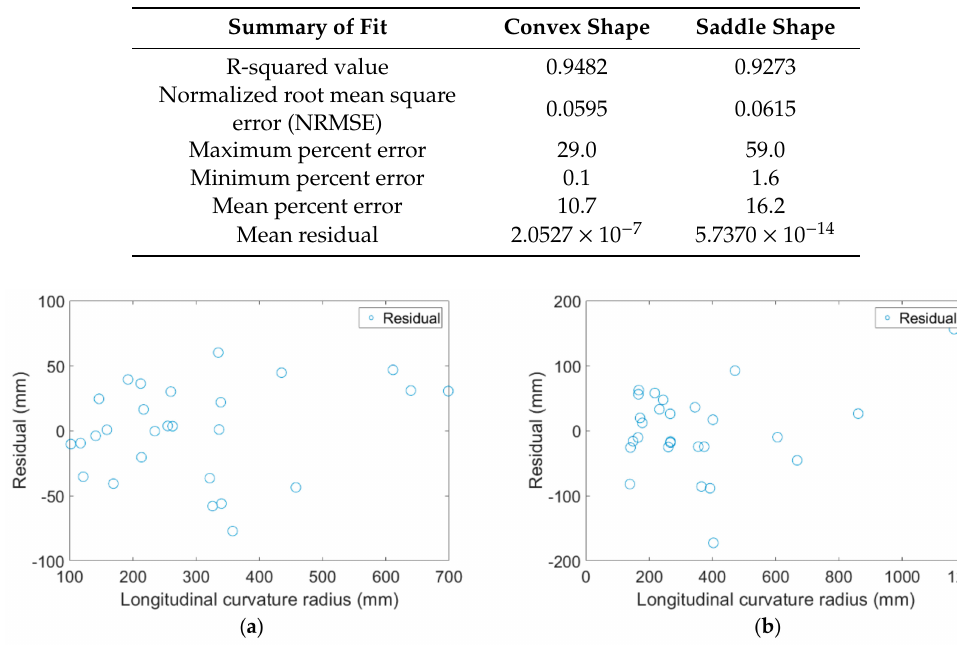
Figure 10. Plot of residuals. ( a ) Convex shape and ( b ) saddle shape.